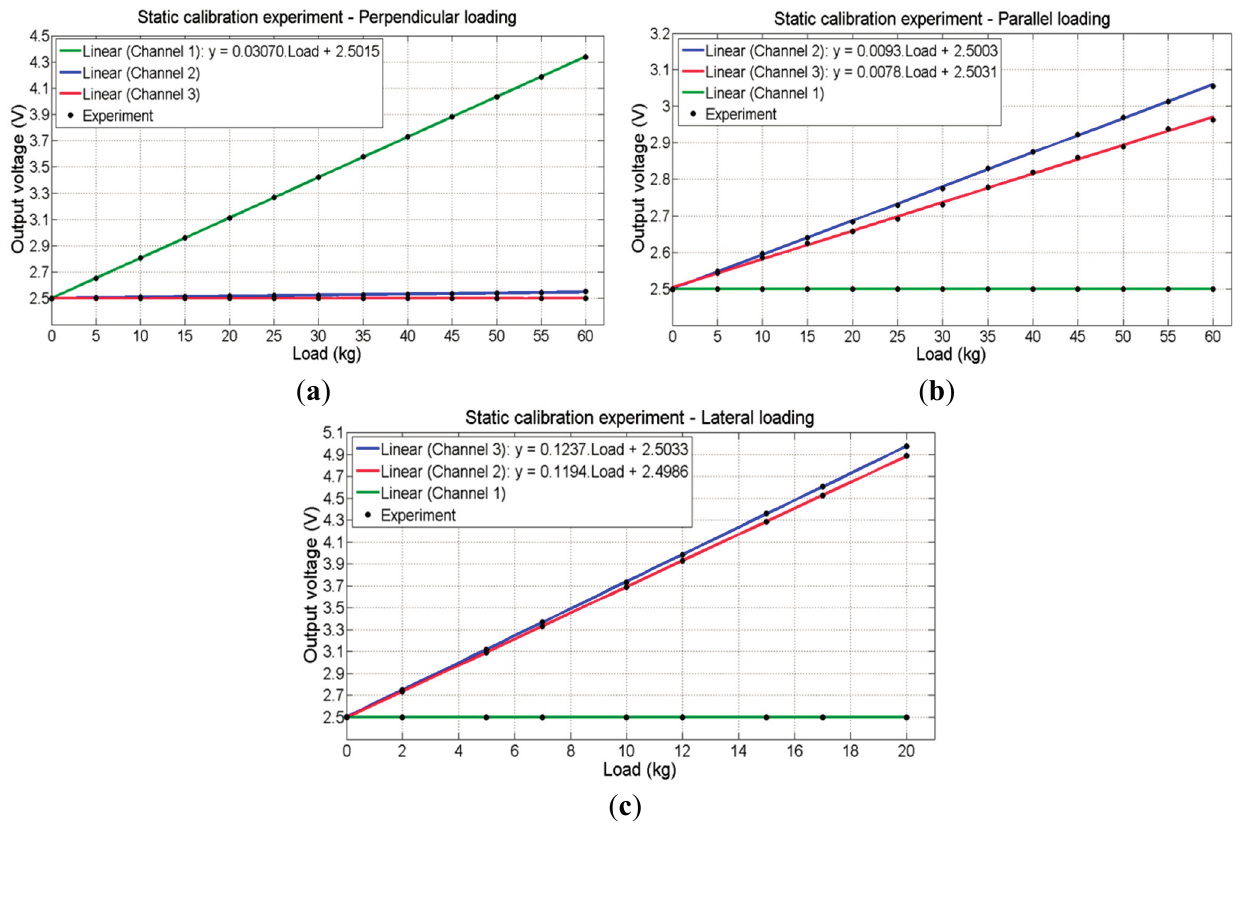
Figure 13. Deformation experiment: ( a ) perpendicular; ( b ) parallel; ( c ) lateral